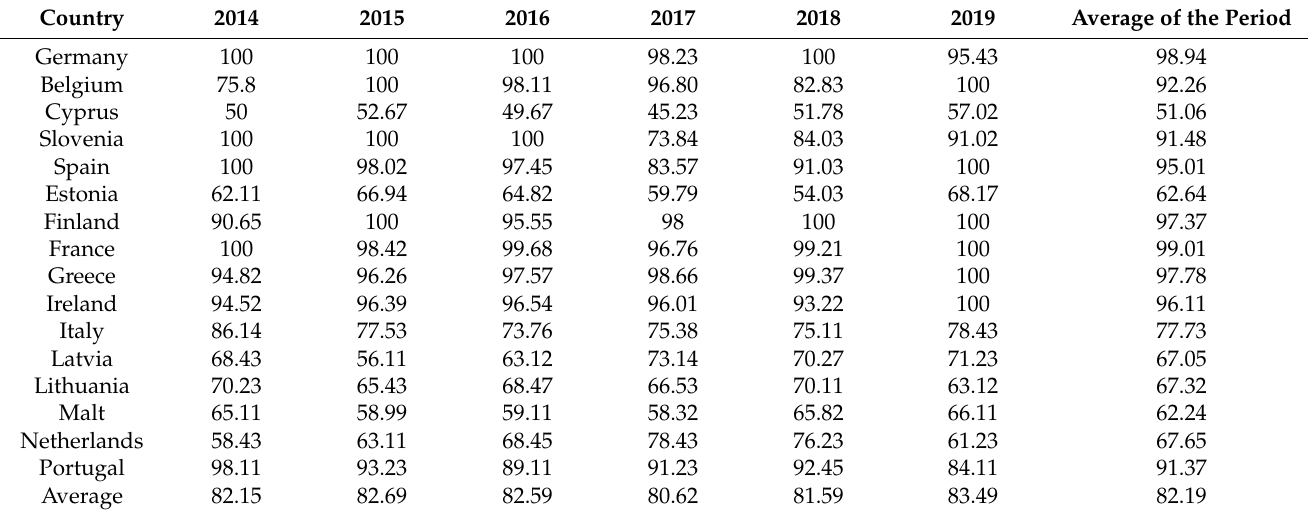
Table 3. Relative efficiency of the countries for the period 2014–2019.